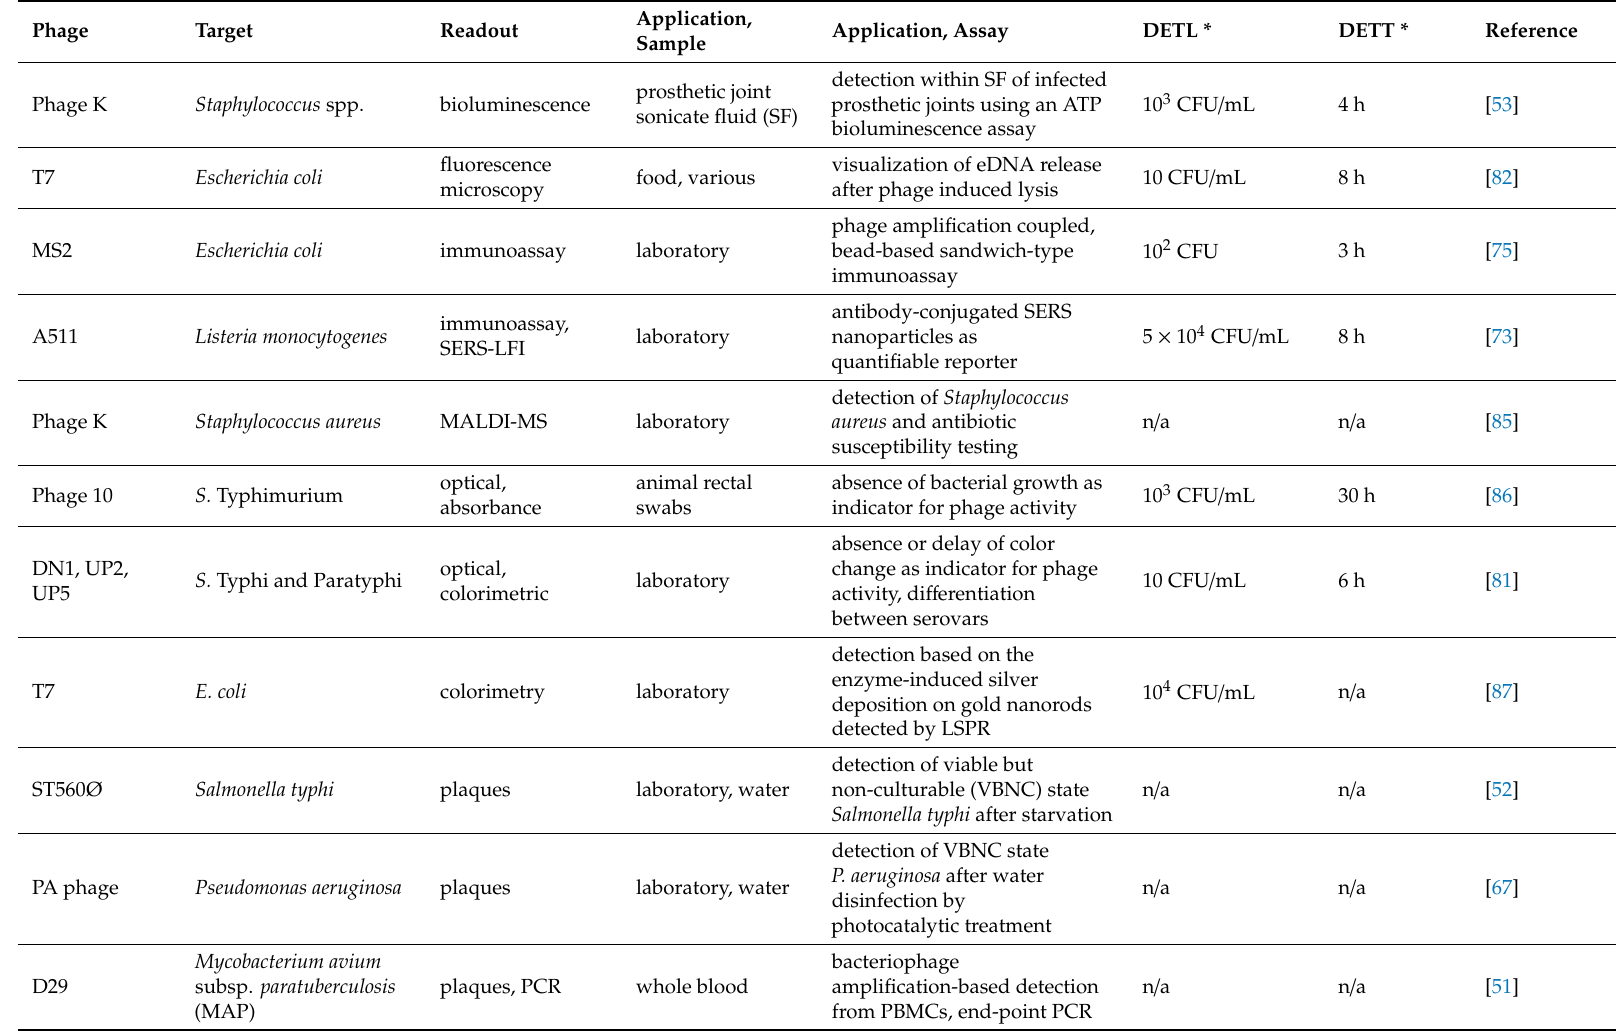
Table 1. Phage amplification-based detection assays published since